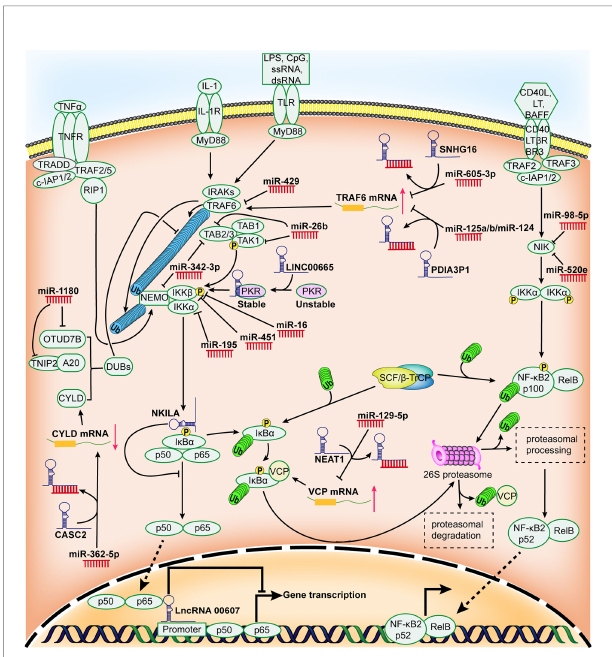
FIGURE 1 | Schematic representation for the role of regulatory ncRNAs in NF- k B signaling pathway in HCC. Many miRNAs and lncRNAs are aberrantly expressed in HCC and they can promote or restrain the expression of HCC- associated genes by modulating certain components of NF- k B signaling pathway and/or the activity of NF- k